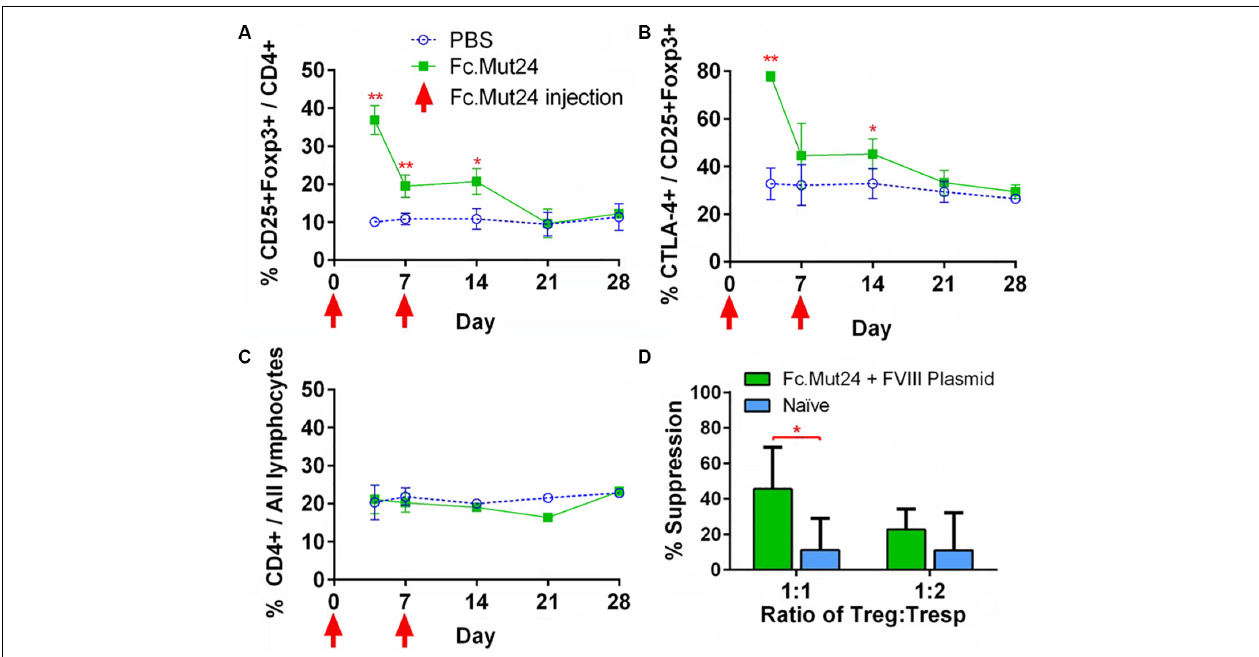
FIGURE 4 | Characterization and functional evaluation of CD4 + splenocytes in Fc.Mut24-treated and FVIII plasmid gene therapy-treated mice. (A–C) Splenocytes were isolated from mice receiving Fc.Mut24 ( n = 3) or PBS ( n = 3) treatment and characterized via flow cytometry for comparison with peripheral blood lymphocytes. The experiments were repeated three times without significant variation. The data are presented as means with standard deviation (* p < 0.05, ** p < 0.01). The p -values were calculated at individual time points by non-parametric Mann–Whitney U test. (D) A suppression assay was performed using CD4 + CD25 + Tregs isolated on Day 50 after an initial treatment from the spleens of mice receiving Fc.Mut24 and FVIII plasmid or from naïve mice ( n = 6 for all groups). Tregs were cultured in vitro with CD4 + cells isolated from the spleens of inhibitor-positive hemophilia A mice as well as irradiated antigen presenting cells. FVIII was added at 10 U/ml in culture media for 4 days. FVIII-specific cell proliferation was measured by an EdU incorporation assay and analyzed via flow cytometry. The suppression of CD4 + cell proliferation was compared to CD4 + cell proliferation in the absence of Tregs. The data are presented as means with standard deviation from two separate experiments (* p <